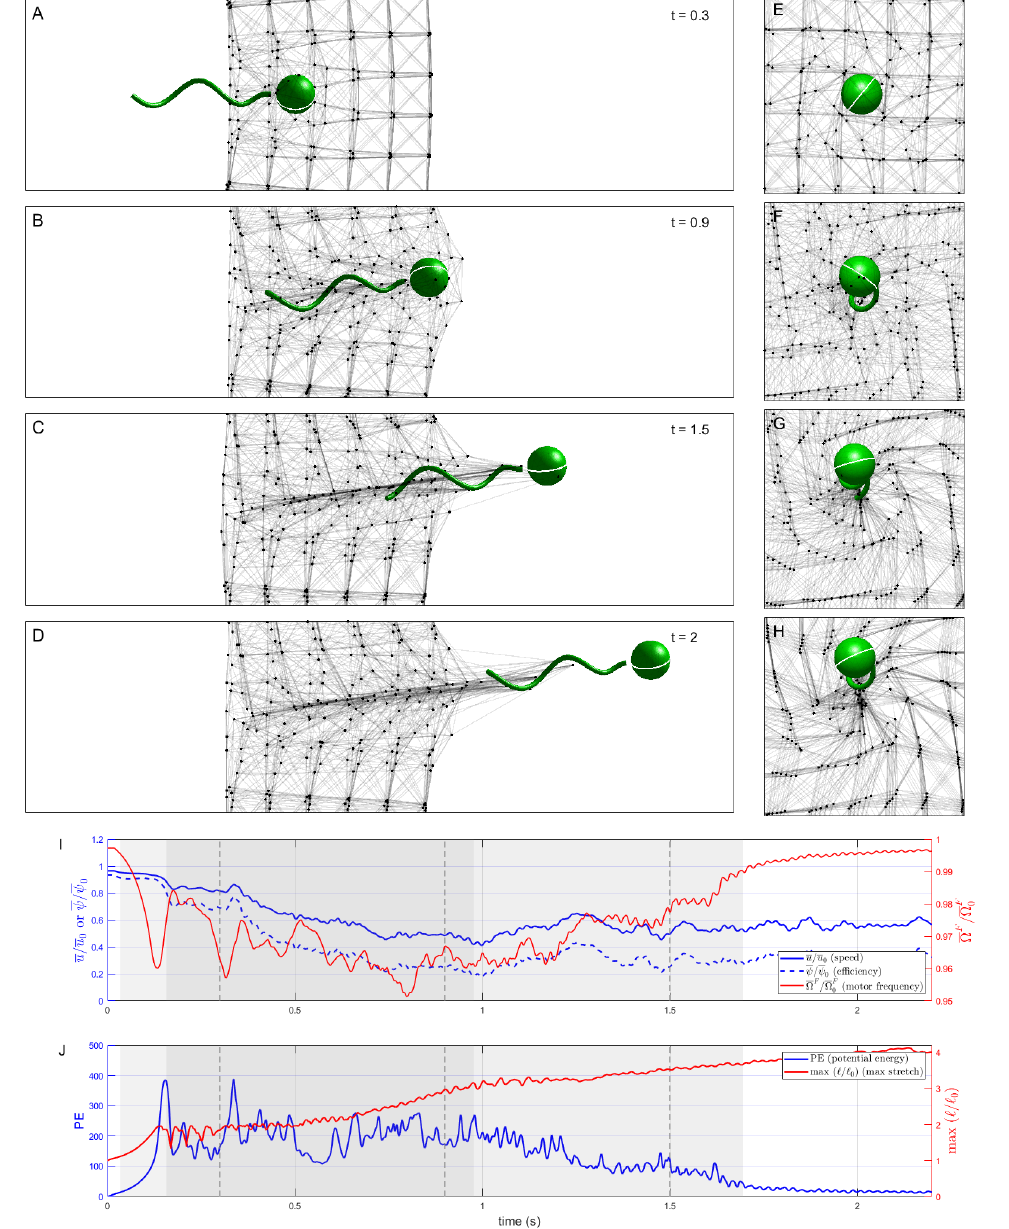
Figure 5. Summary of results for E = 25 mPa, η = 1 mPa-s. See Figure 3 for panel descriptions. See in Supplementary Materials Video S3 for an animated